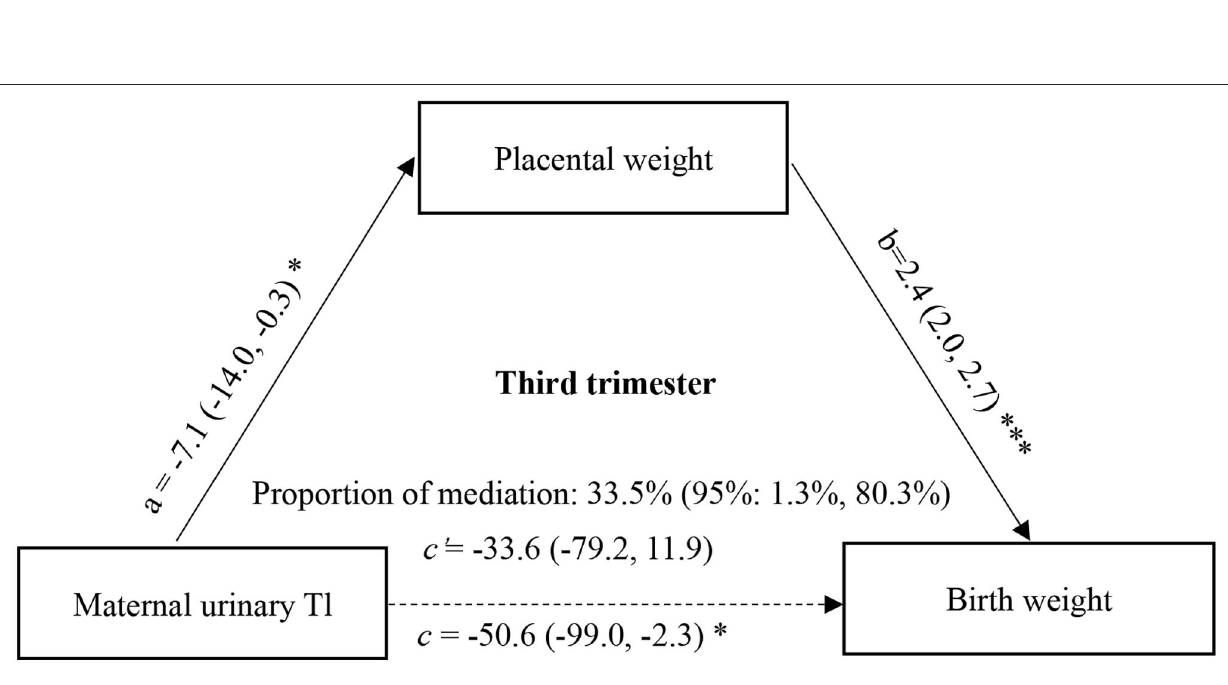
Frontiers in Public Health |